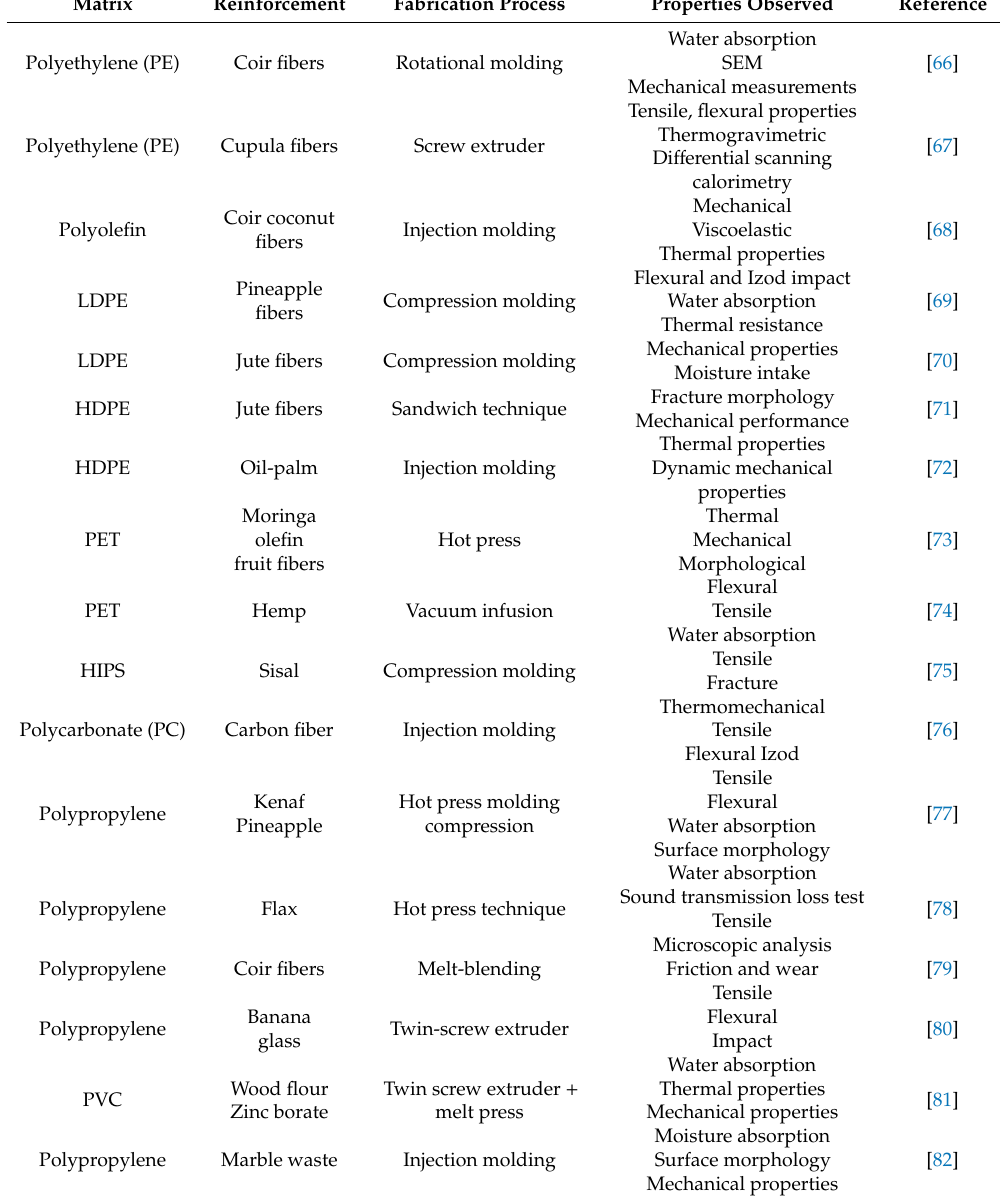
Table 9. Recent research on thermoplastic hybrid composites and fabrication